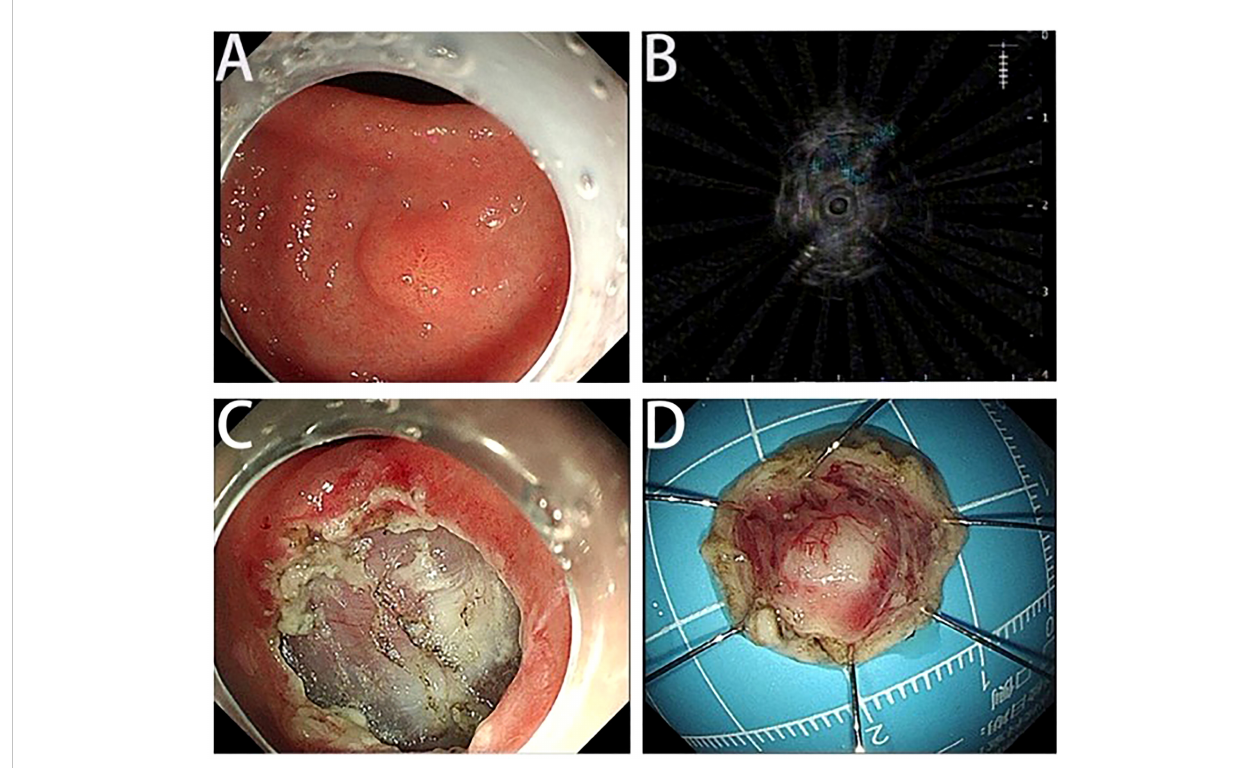
FIGURE 1 Endoscopic and endoscopic ultrasound fi ndings and ESE images. (A) The upper gastrointestinal endoscopy shows a submucosal protrusion at the lesser curvature of gastric antrum. The tumor surface is covered by normal gastric mucosa. (B) The EUS shows the hypoechoic lesion originating from the submucosa. (C) The wounds after ESE. (D) The resected tumor